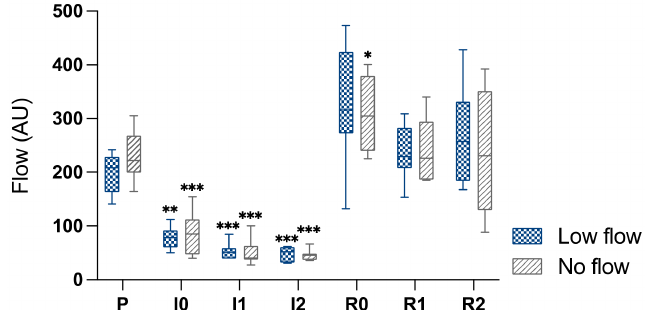
Figure 3. Box-plot diagram of the intestinal microperfusion measured by LDS in arbitrary units (AU) during the different time points. P, pre-ischaemia; I0, immediately after induction of ischaemia; I1, 60 min ischaemia; I2, 120 min ischaemia; R0, immediately following reperfusion; R1, 60 min reperfusion; R2, 120 min reperfusion. The horizontal bar displays the median, the interquartile range is represented by the box, and the minimum and maximum by the whisker plots. Significant differences of the time points compared to pre-ischaemia are marked with an asterisk (* p < 0.05; ** p < 0.01; p *** < 0.001). There were no significant differences between the groups.